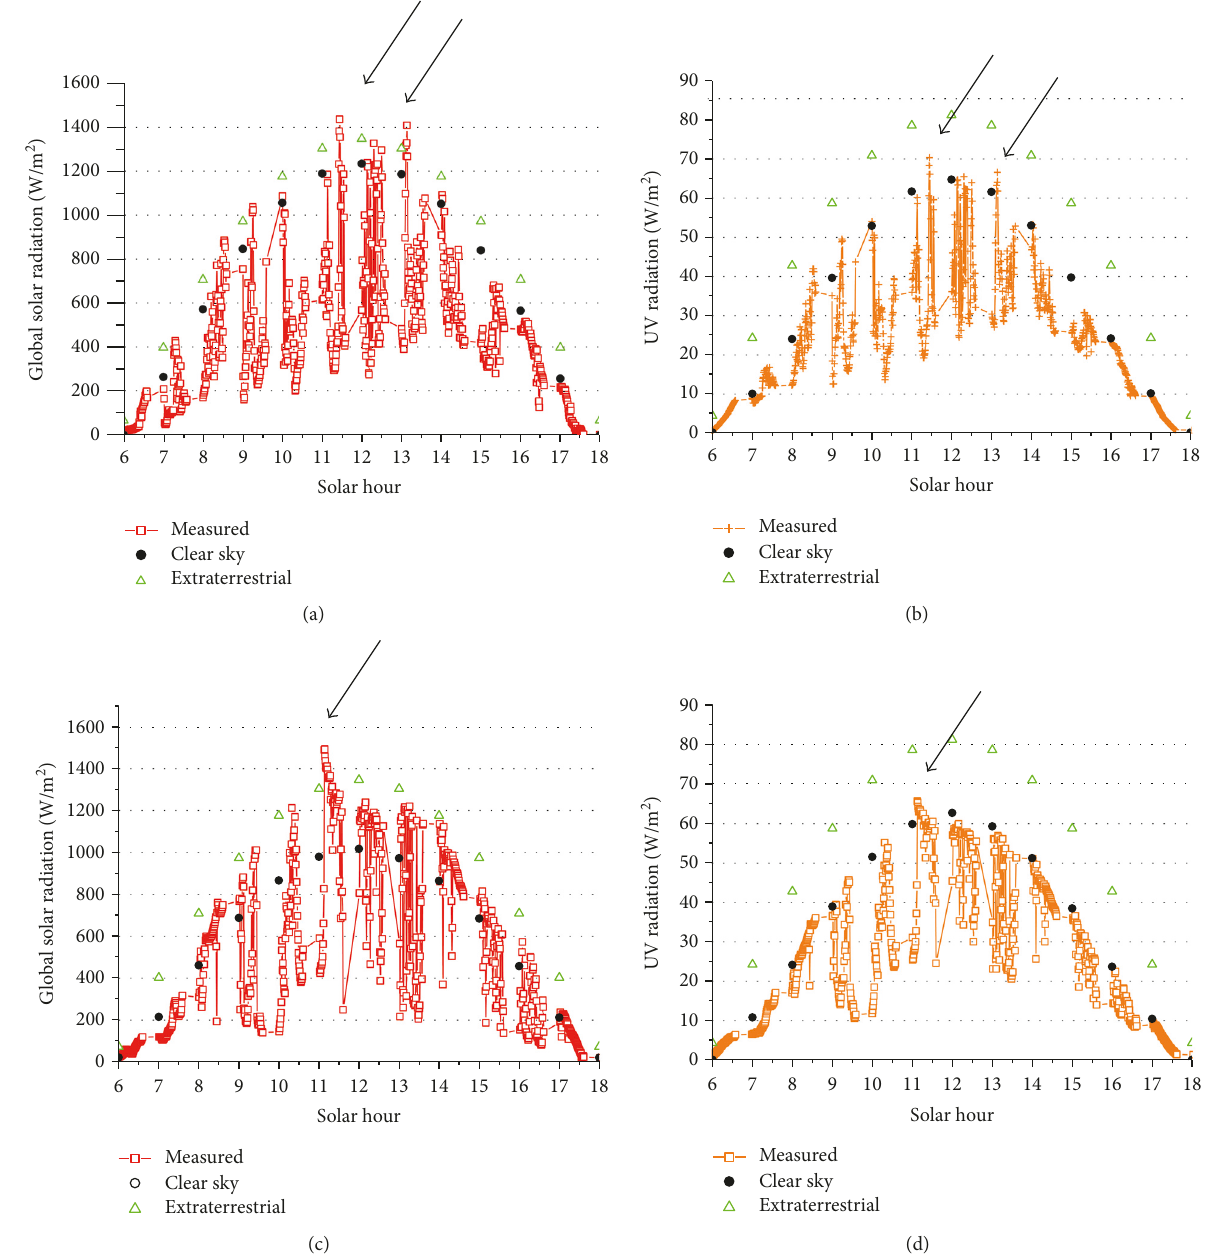
Figure 4: Behavior of global solar and UV (A +B) radiation for the day of October 9 (a and b) and January 15, 2011 (c and